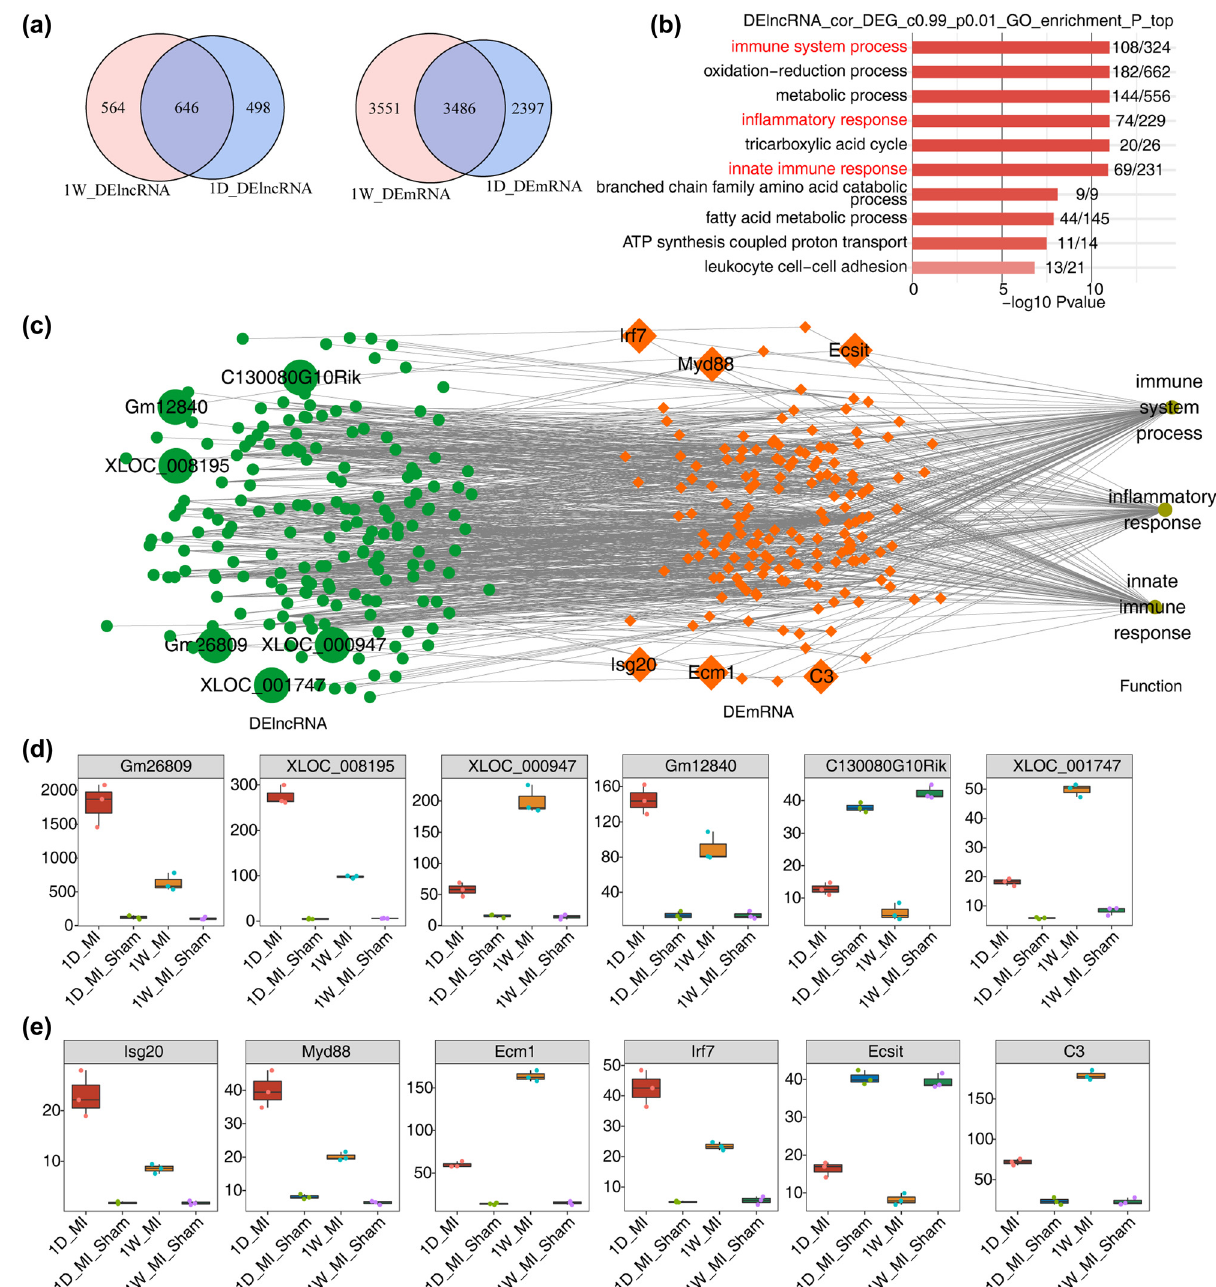
Figure 3: Coexpression network illustration between DE lncRNAs and DE mRNAs. ( a ) Venn diagram of DE lncRNAs and DE mRNAs in MI and sham samples; ( b ) The top 10 enriched GO biological process pathways by DE lncRNAs coexpressed with DE mRNAs of MI compared with sham samples. ( c ) The coexpression network between DE lncRNAs and DE mRNAs involved in the top 3 immune - related terms shown in ( b ) . lncRNAs are on the left, coexpressed mRNAs are in the center, and the mRNA - enriched GO terms are on the right. ( d and e ) Boxplots showing the expression of six DE lncRNAs and six DE mRNAs in MI and sham